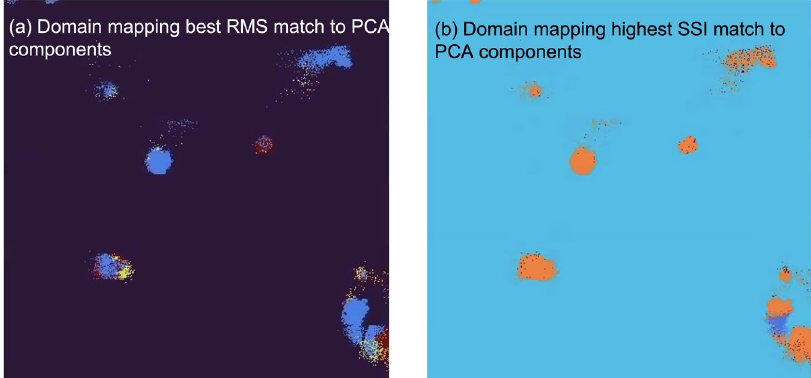
Fig. 11 Comparison of metrics on the direct NMF centroids. The domain maps are produced by direct NMF using an RMS comparison metric ( a ) and an SSI comparison metric ( b